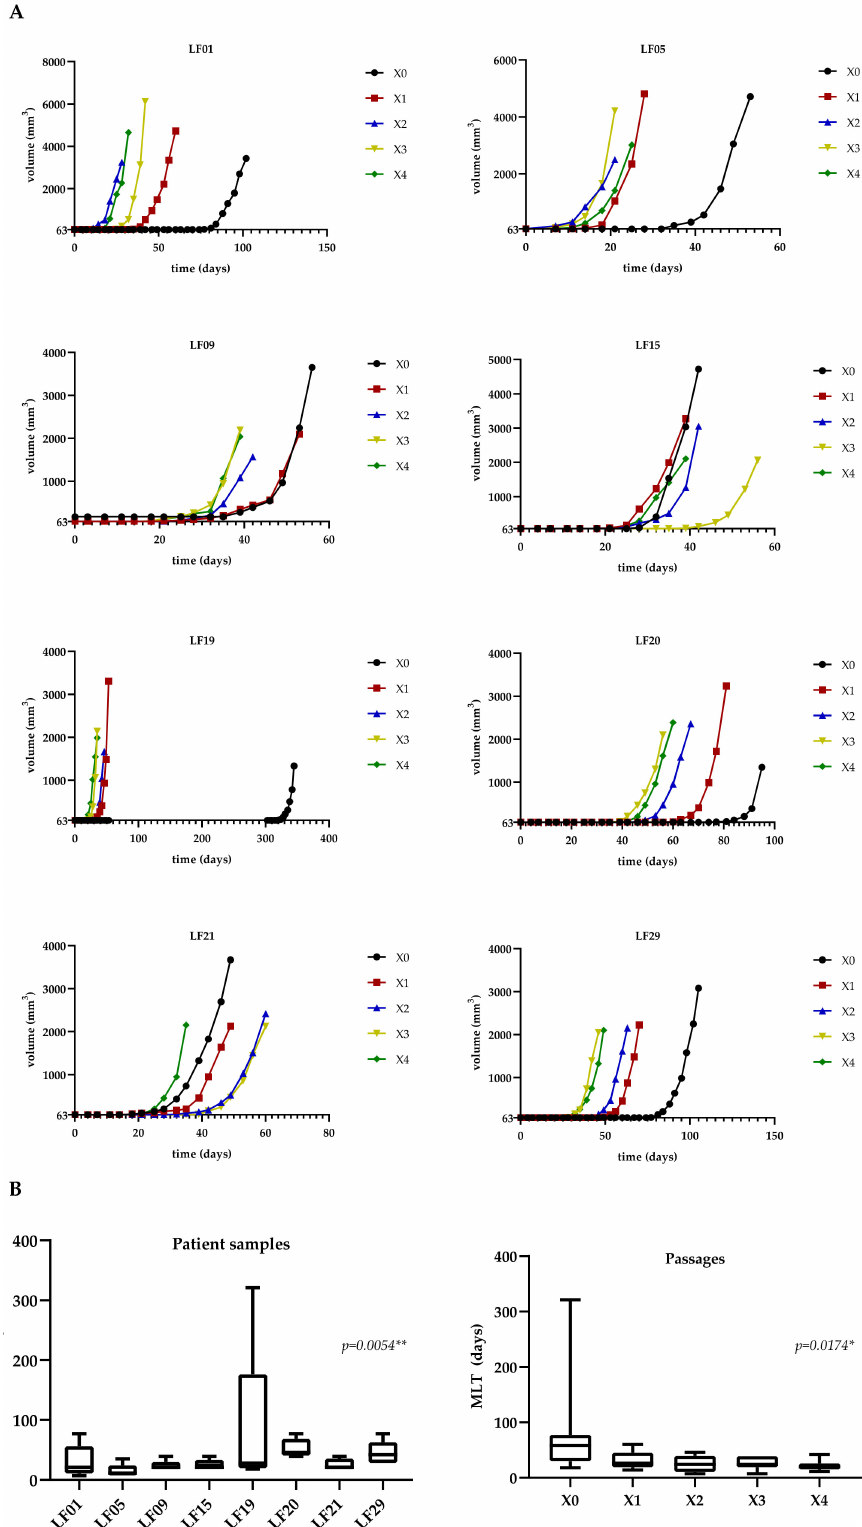
Figure 3. PDX tumor growth curves and median latency times. ( A ) Growth curves of PDX tumors of passages X0 to X4 from each sample are represented as volume (mm 3 ) per time (days). The primary tumor implantation in mice is X0 and the last PDX tumor passage is X4; ( B ) Friedman test statistics of MLT data. ( Left panel ) Friedman test statistics of MLT data for all patient samples. ( Right panel ) Friedman test statistics of MLT data for all